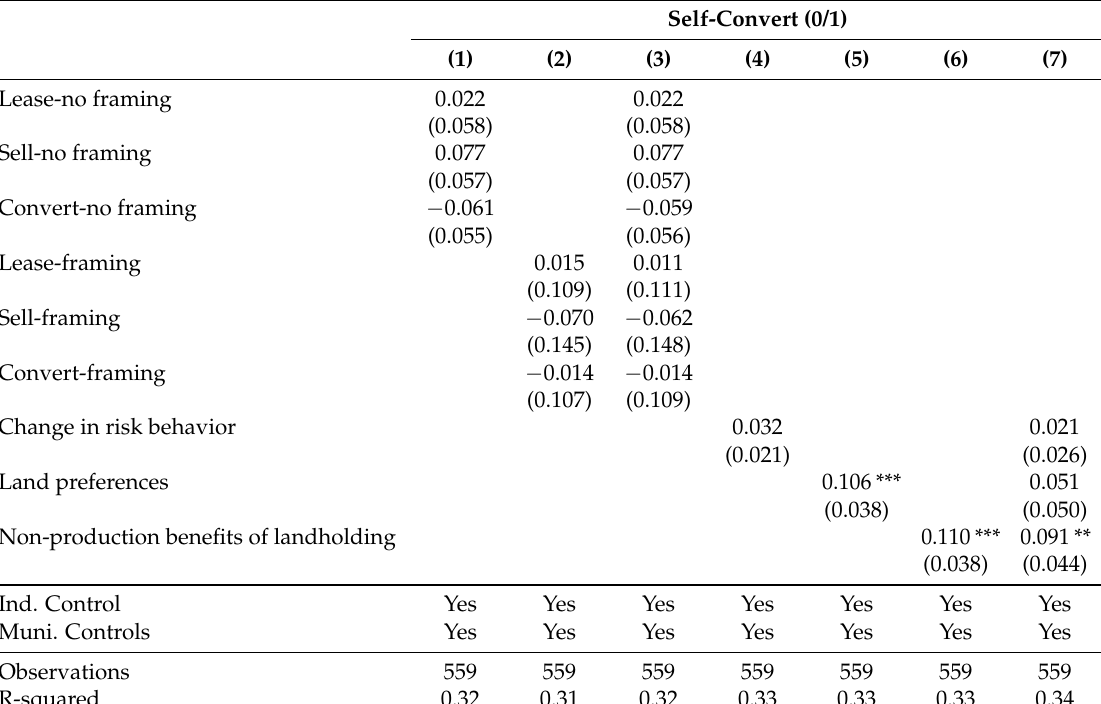
Table 9. Predictors of self-conversion of pasture to cropland.